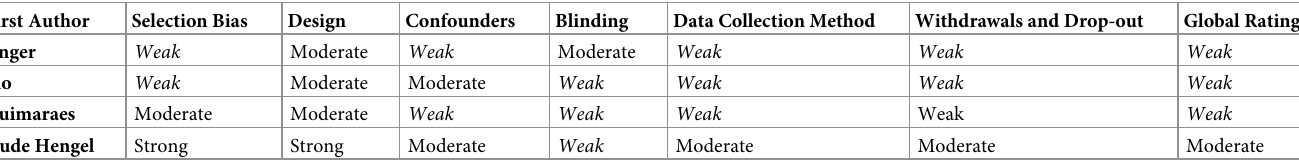
Table 4. Summary of quality appraisal